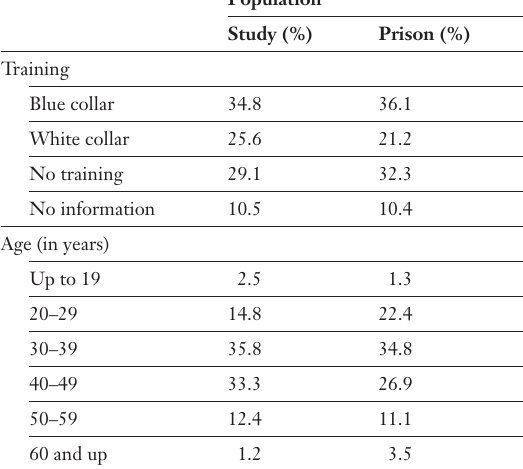
Table 1 Distribution of voca- tional training and age in study sample and offender popula- tion of largest prison (“Pöschwies”) in Switzerland in